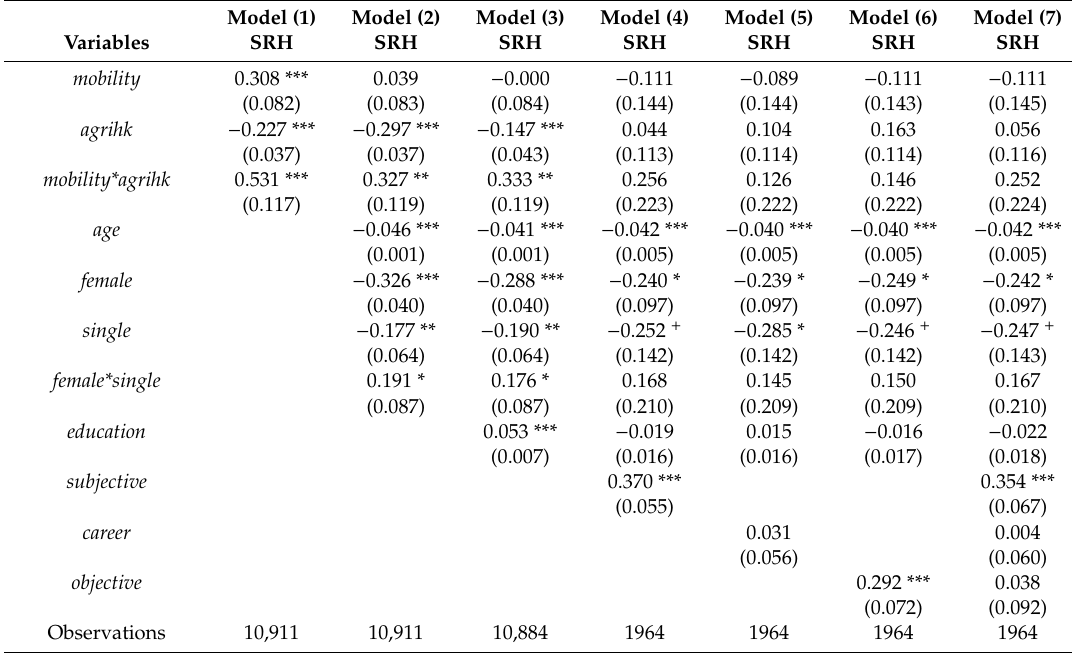
Table 10. The result of ordered logit